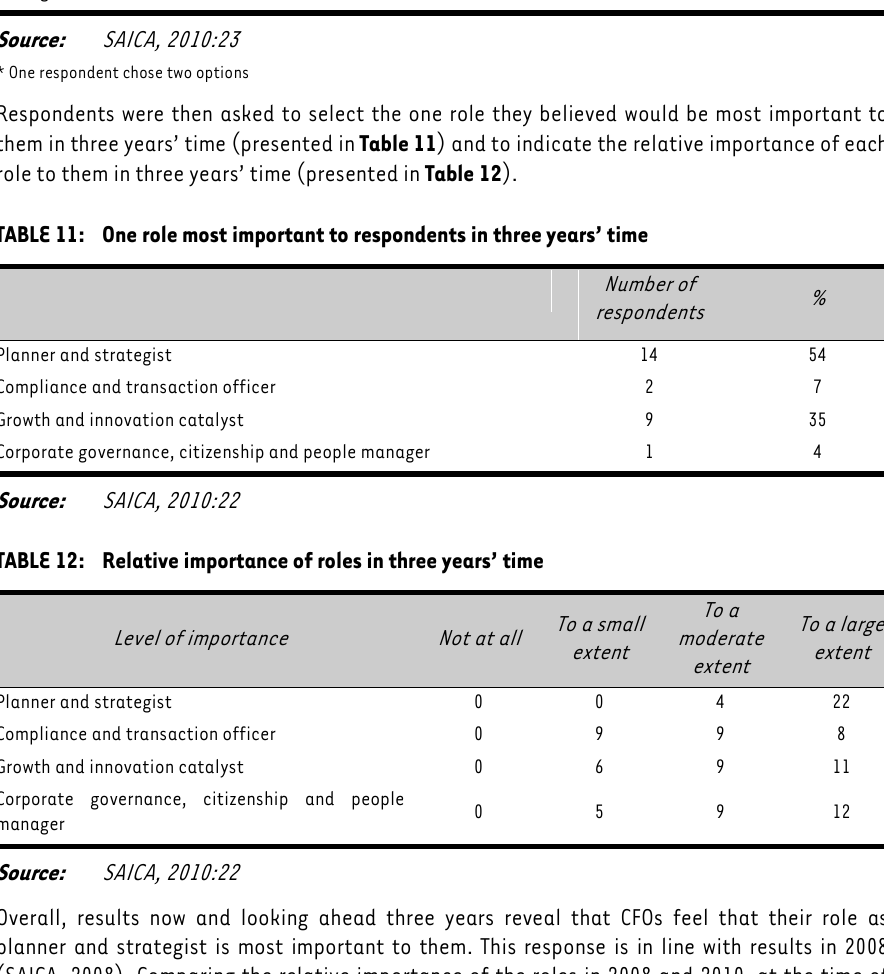
TABLE 11: One role most important to respondents in three years’ time